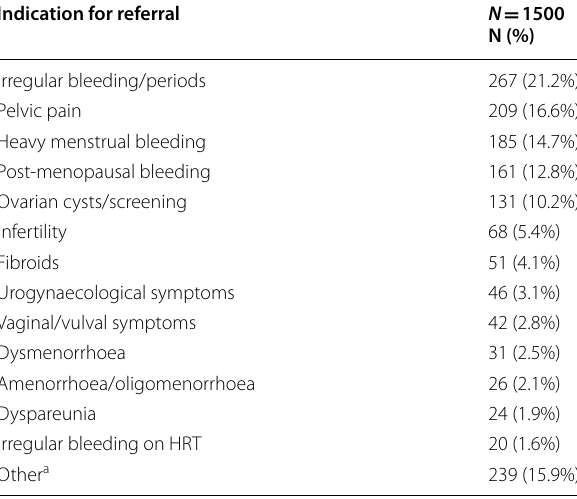
Table 2 Indications for transvaginal ultrasound examination